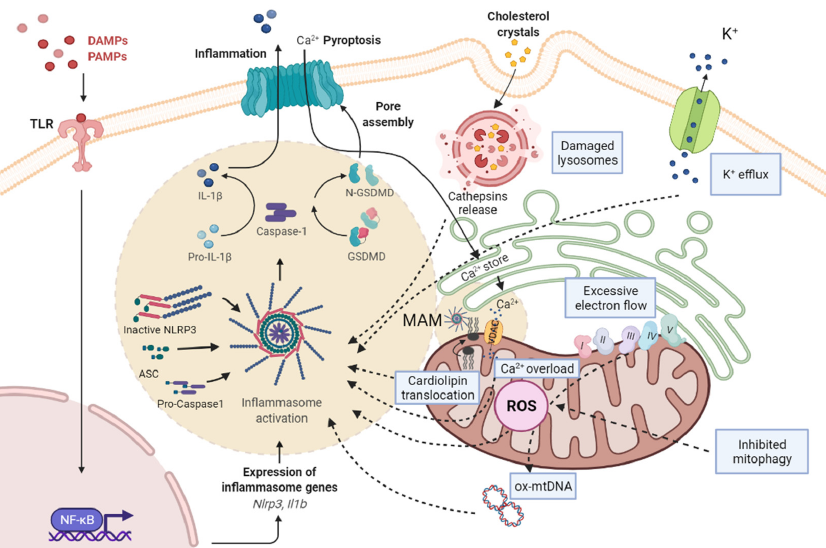
Figure 1. Scheme of the pathways associated with NRLP3 inflammasome activation and mitochon- drial dysfunction. PAMPs and DAMPs are recognized by TLR, as priming signal, and activate NF- κ B signaling pathway, promoting the transcription of pro-IL-1 β and NLRP3, while an activation signal initiates the formation of NLRP3/ASC/pro-caspase-1 complex. Subsequently, the active form of caspase-1 cleaves pro-IL-1 β to mature IL-1 β and GSDMD into a N-terminal fragment (N- GSDMD). N-GSDMD produces pores in the membrane, allowing the release of IL-1 β into the extra- cellular space. The mechanisms involved in NLRP3 activation include: the destabilization of the ion outflow (K + efflux/Ca 2+ influx) creating holes in the cell membrane; the release of ROS by damaged mitochondria produced by excessive electron flow; an inhibited mitophagy and mtDNA oxidation; and the release of cathepsins by damaged lysosomes. The NLRP3 inflammasome complex activation is located in MAMs, where cardiolipin translocation and Ca 2+ influx by VDAC occurs, and facilitates the assembly of the NLRP3 inflammasome. ASC, adaptor apoptosis speck protein; DAMPS, dam- age-associated molecular patterns; GSDMD, gasdermin D; IL-1 β , interleukin-1 β ; MAM, mitochon- dria-associated membranes; NF-kB, nuclear factor kappa B; NLRP3, NLR family pyrin domain con- taining 3; PAMPs, pathogen-associated molecular patterns; ROS, reactive oxygen species; TLR, toll- like receptor.